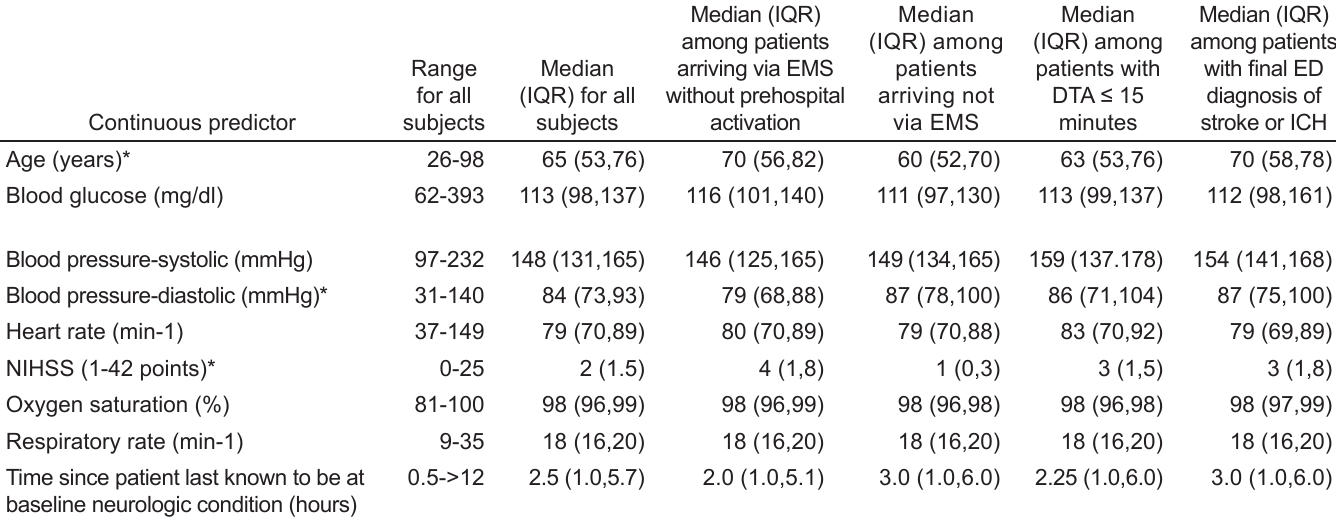
Table 1B. Continuous predictor variables and study subject characteristics.